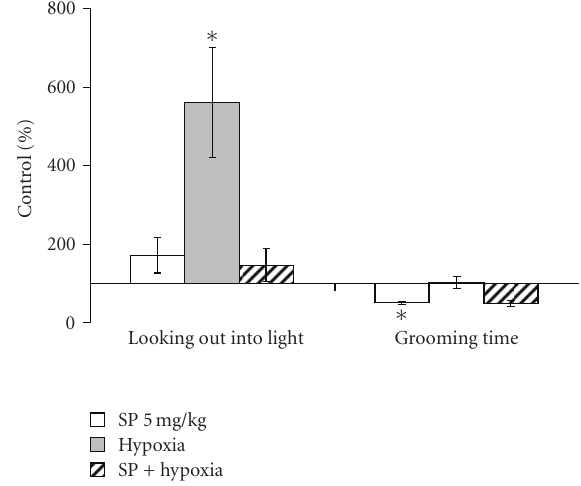
Figure 6: Influence of the pre-treatment with 5mg/kg SP on the behavioral e ff ects of the acute hypobaric hypoxia of pregnant rats with low resistance to hypoxia in the elevated plus maze test 24 hours after hypoxia. Statistical significance: ∗ P < . 05 .